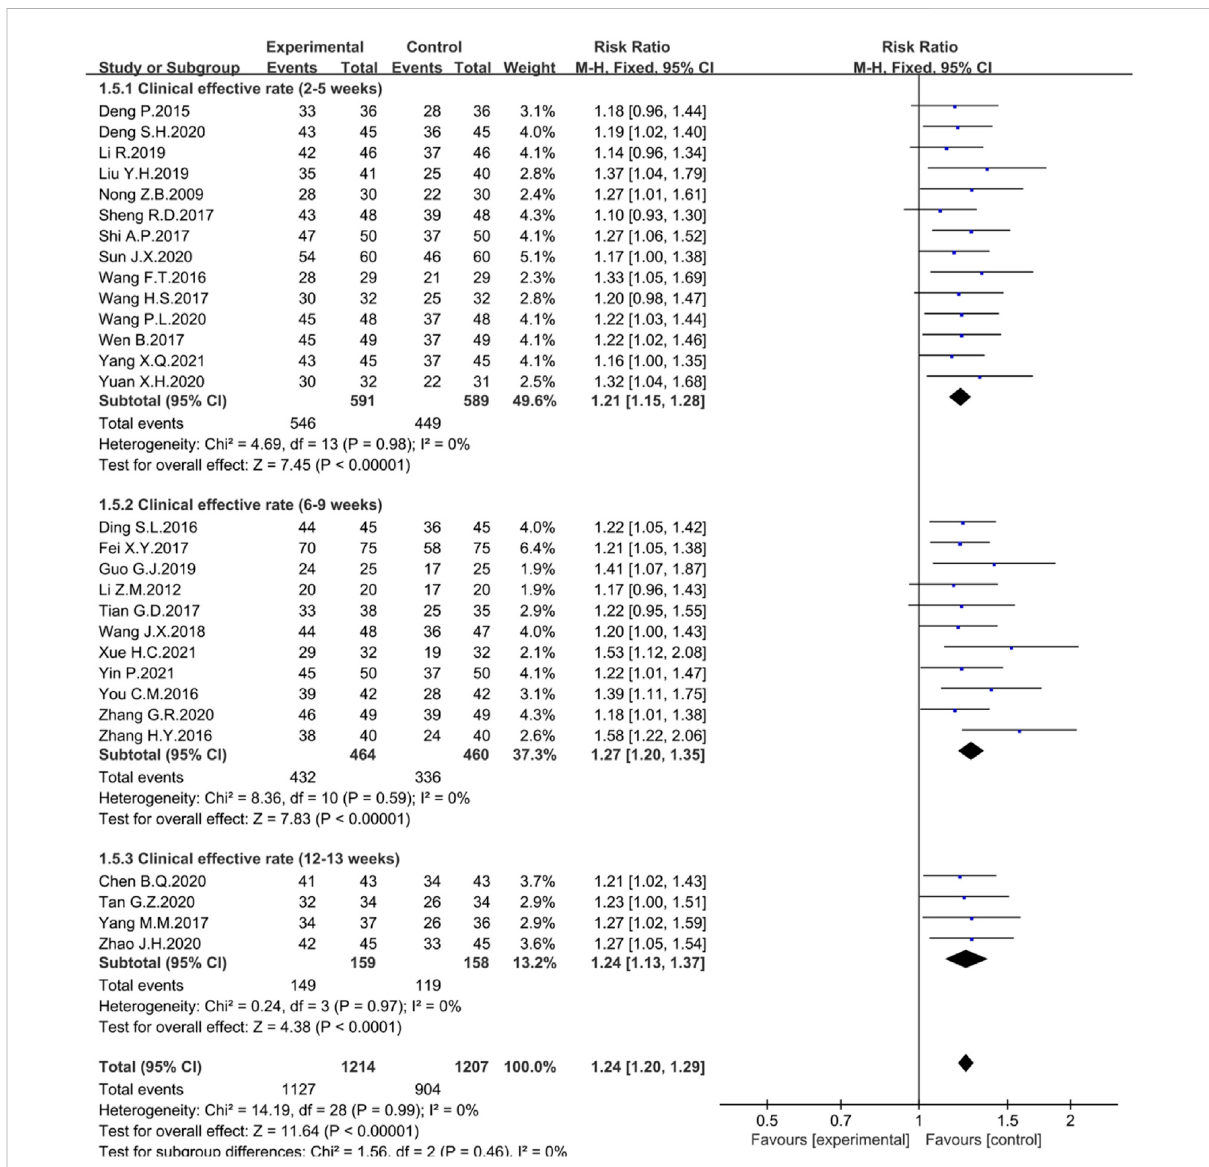
FIGURE 6 Forest plot displaying the results of the Meta-analysis for clinical ef fi ciency in different courses of